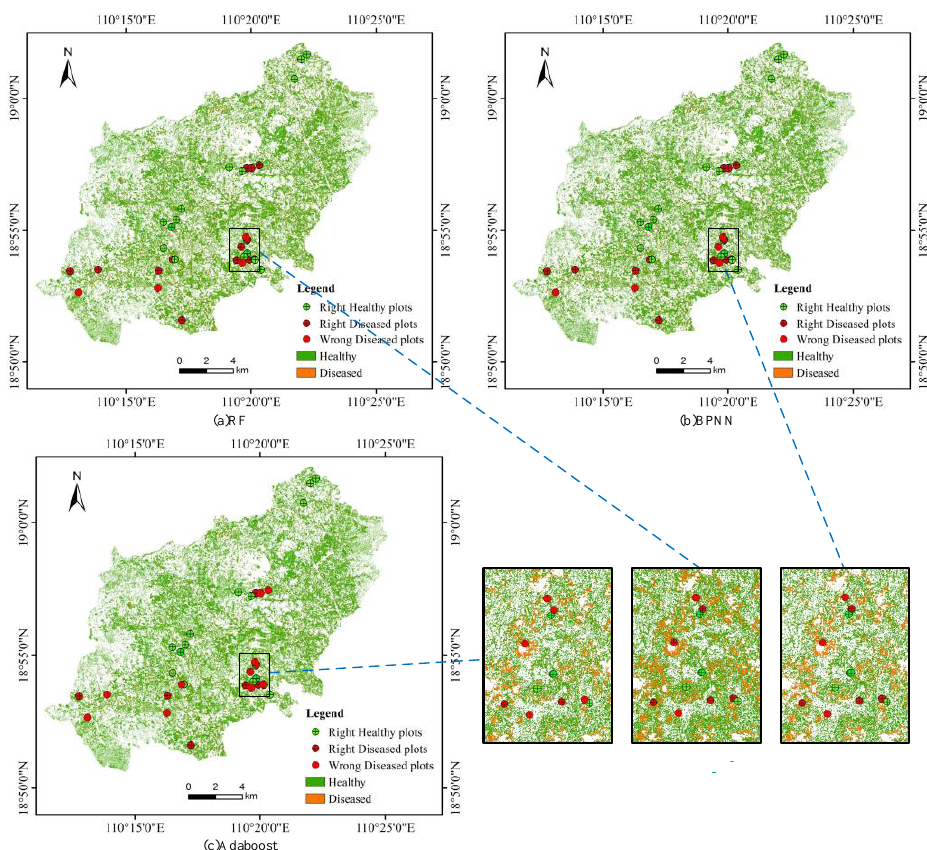
Figure 3. Distribution map and detail view of areca yellow leaf disease severity determined from Planet imagery via ( a ) RF, ( b ) BPNN and ( c ) AdaBoost.